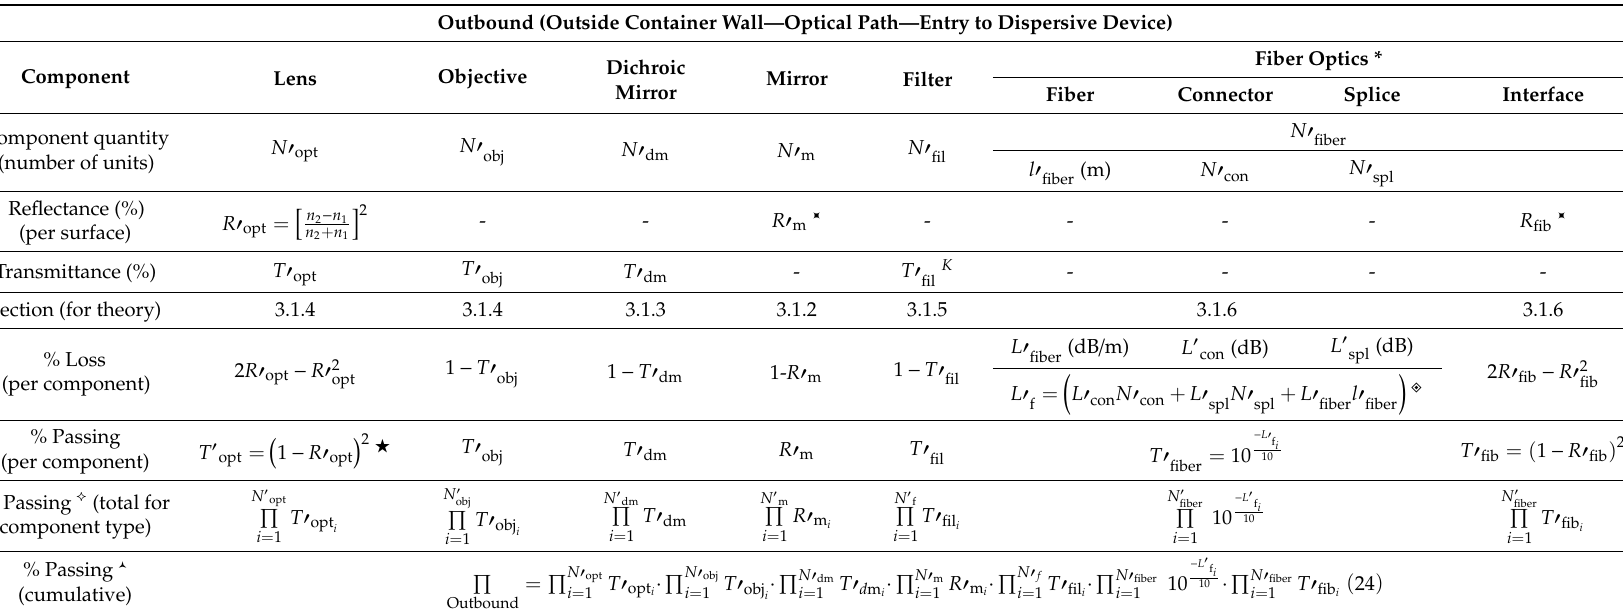
Table 3. Summary of light intensity transfer function for inbound optical path.